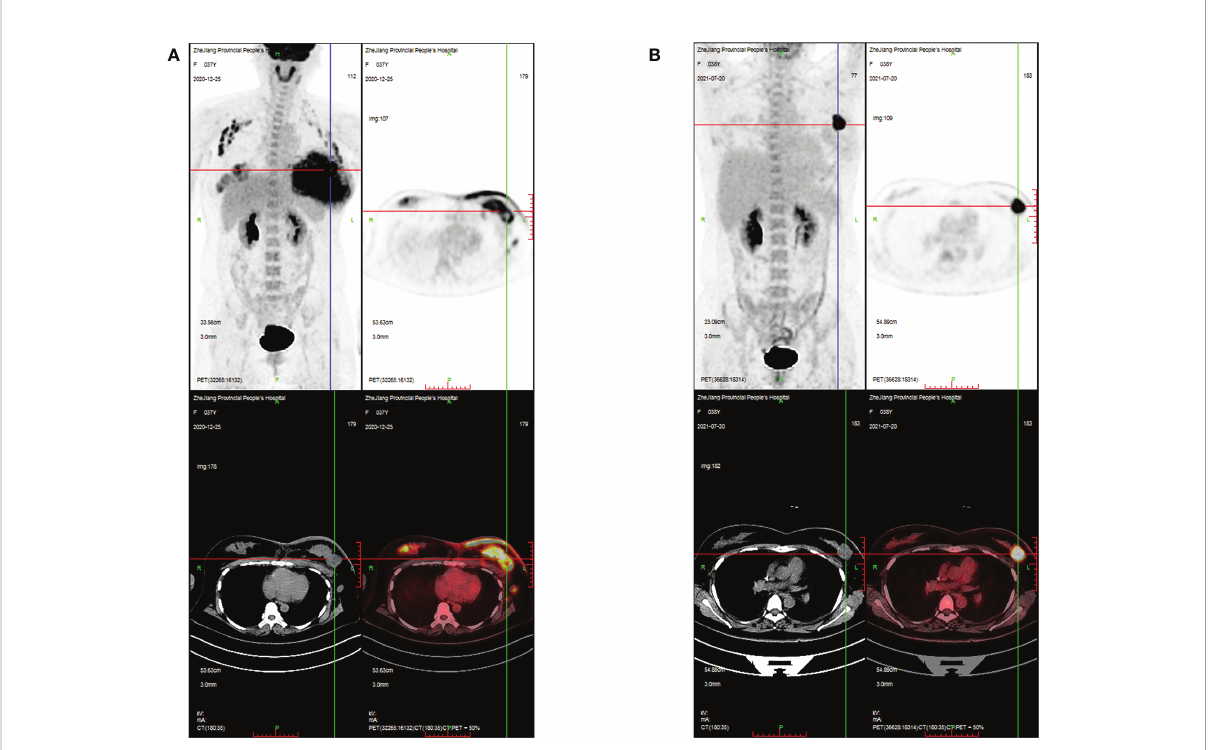
FIGURE 2 PET/CT images evaluating the changes in breast masses and metastatic lymph nodes during treatment in case 1. (A) PET/CT images showing intense FDG uptake in the bilateral breast, bilateral axilla, left clavicular area, and left upper mediastinum at the time of initial diagnosis; (B) PET/ CT images showing that areas of high FDG uptake in the breast and lymph nodes were signi fi cantly reduced after 10 cycles of